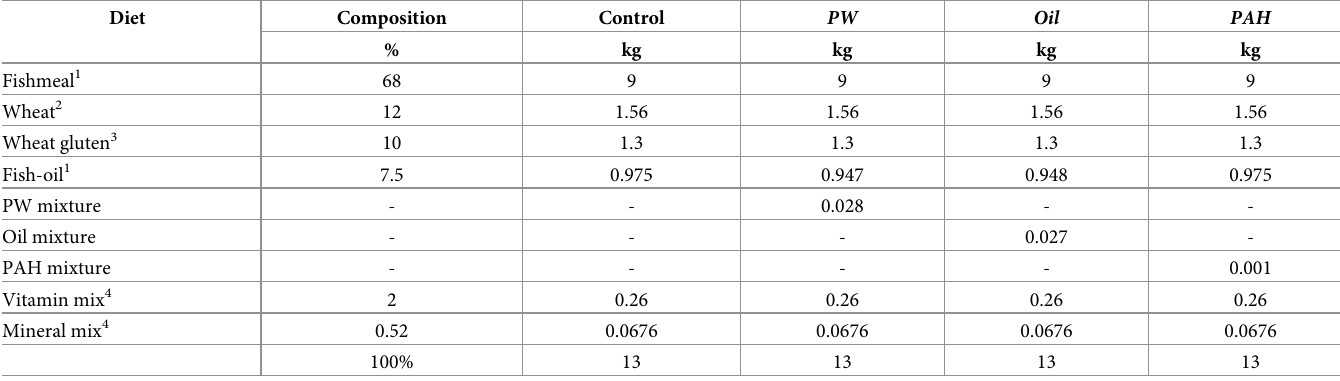
Table 1. Composition of the experimental